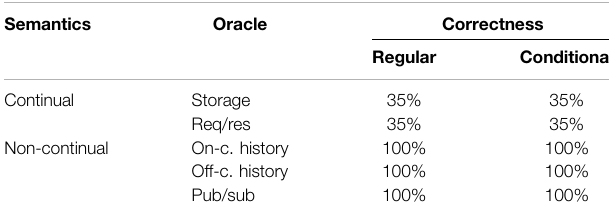
TABLE 3 | Correctness of approaches in n (cid:1) 60 random scenarios.